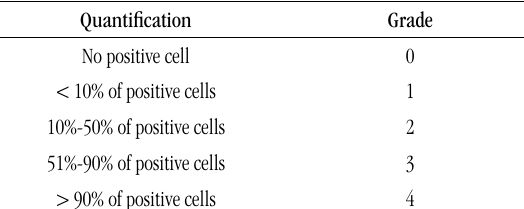
tABLE 2 – Immunoreaction scoring, according to the number of stained cells, for semi-quantitative analysis of slides